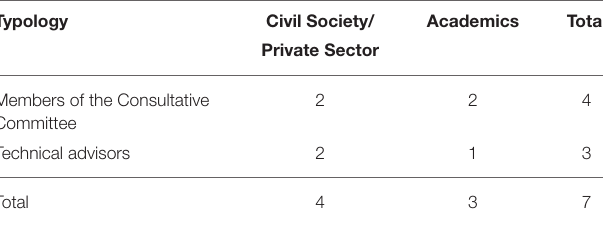
TABLE 1 | Interviewees by typology.